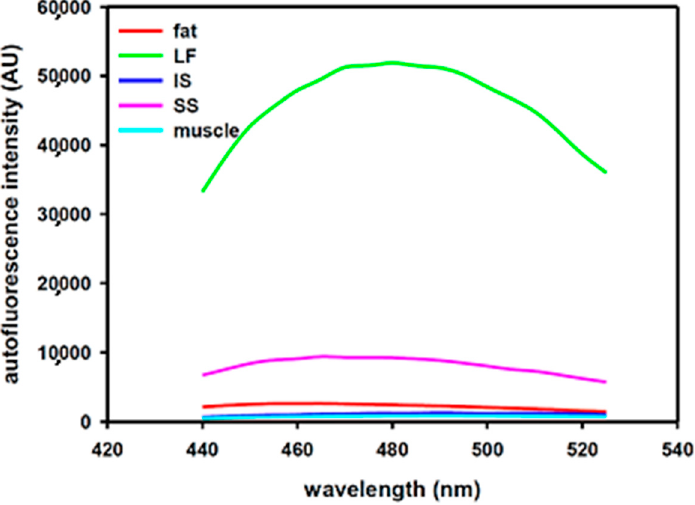
Figure 3. Autofluorescence spectral profiles of fat, interspinous ligament and ligamentum flavum. It should be noticed that the spectra were collected using the microplate reader.